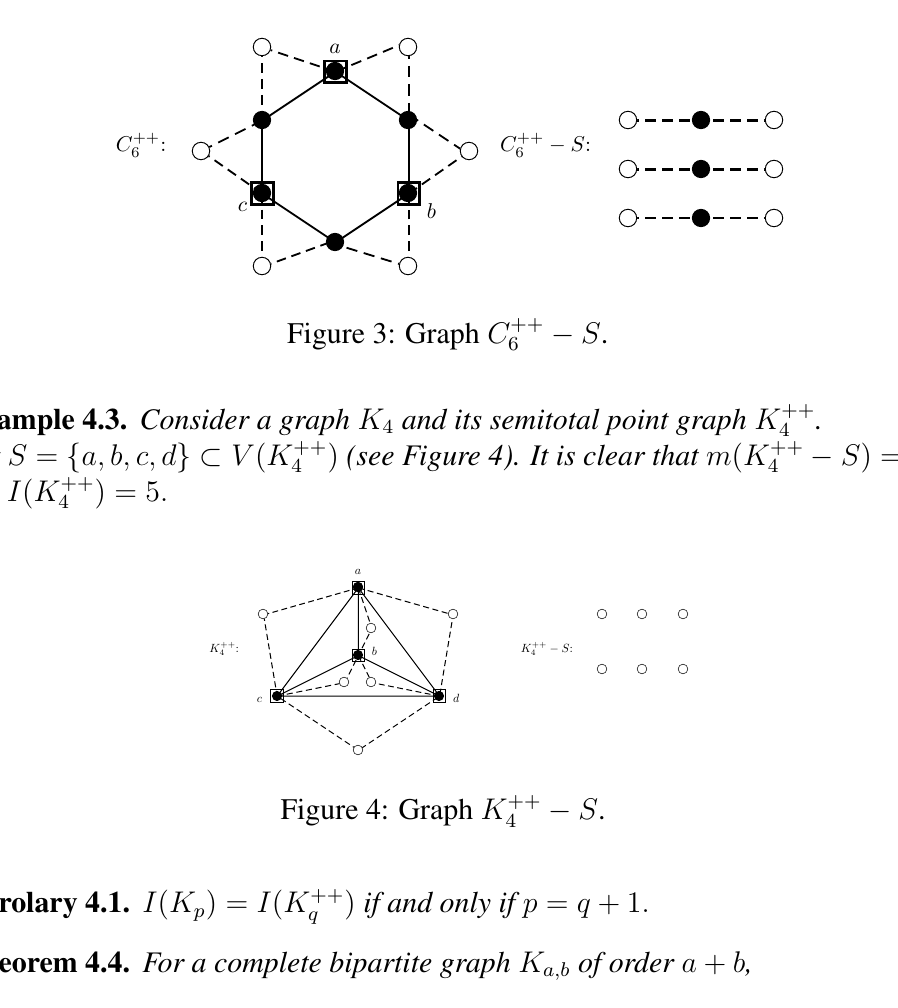
Figure 4: Graph K ++